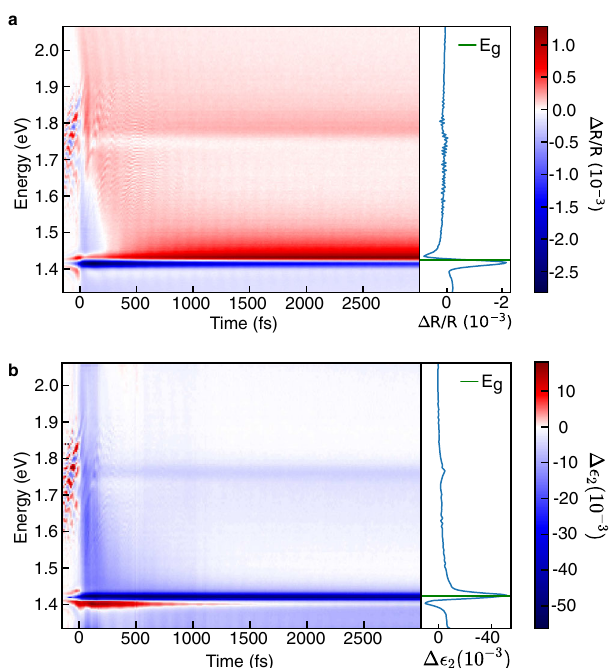
Fig. 4 Interpretation of the transient re fl ection response of a GaAs wafer. a Broadband transient re fl ection map and spectral cut at 500 fs (blue line) indicating that the transient spectral features are unconventional if interpreted as the transient absorption with the bandgap not lying on any of the spectral features. b Broadband Δ ε 2 extracted using the KK analysis and a spectral cut at 500 fs (blue line) showing that the broadband spectra now resembles that of a typical inorganic semiconductor with the photobleach of Δ ε 2 occurring at the bandgap. The green line in the side panels indicates the bandgap of